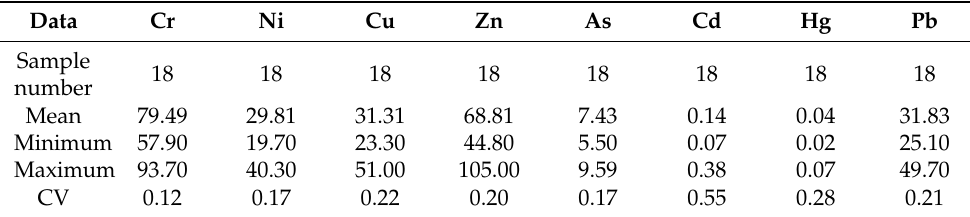
Table 7. Statistical characteristics of heavy metal contents in root–soil (mg/kg).